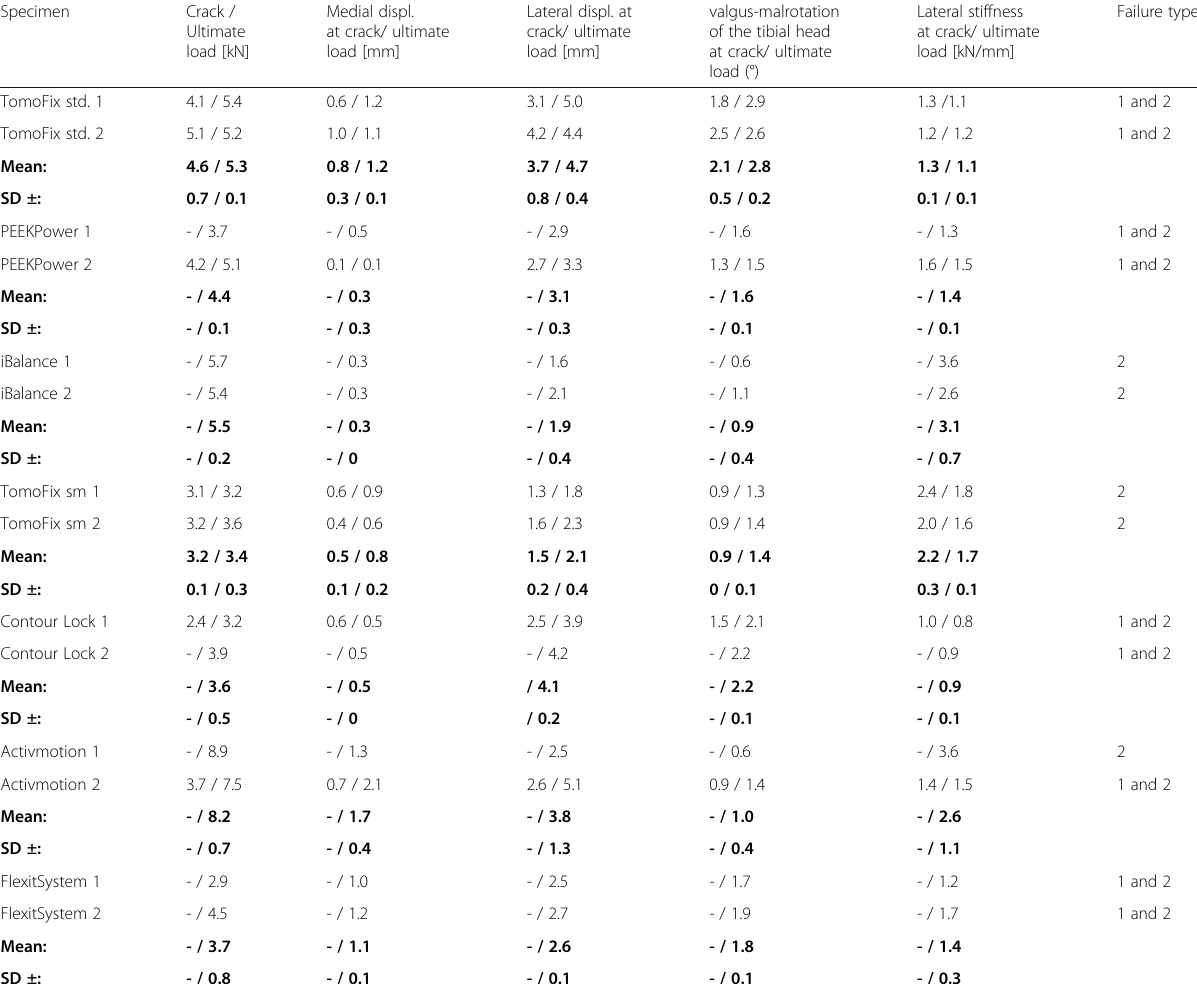
Table 5 Static tests summary